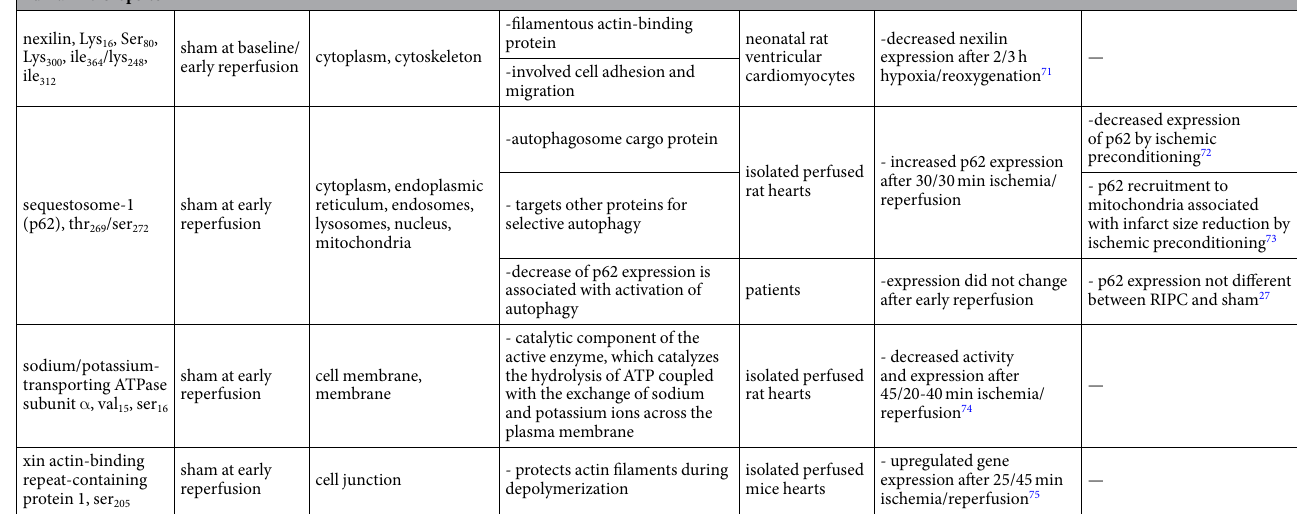
Table 3. Proteins identified in human and porcine LV biopsies with a difference in FDR-based statistical analysis and their role in myocardial ischemia/reperfusion and in cardioprotection.